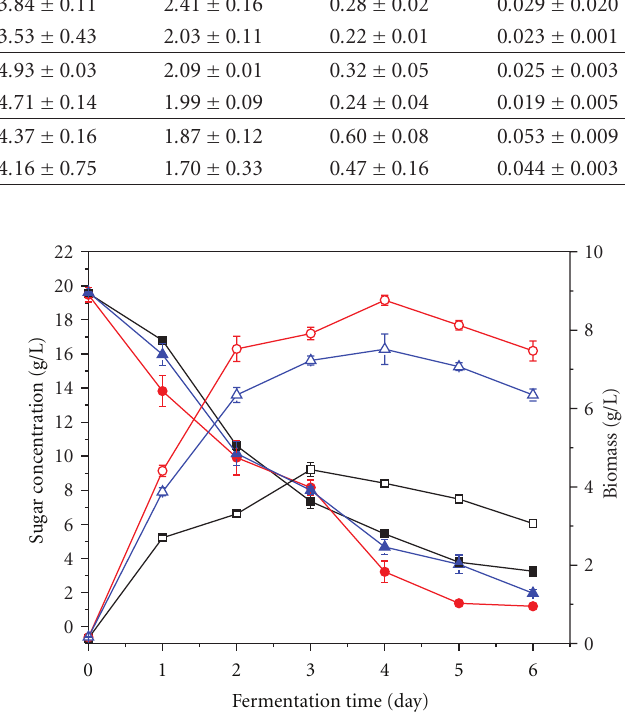
Figure 1: E ff ect of di ff erent types of DRBH on the growth of Y. lipolytica Po1g . Culture conditions: growth in Erlenmeyer flasks; initial total sugar concentration: 20 g/L; pH: 6.5; incubation tem- perature: 26 ◦ C; agitation speed = 150 rpm; biomass concentration: ( (cid:2) ) 2%, ( ◦ ) 3%, ( (cid:3) ) 4%; sugar consumption: ( (cid:3) ) 2%, ( • ) 3%, ( (cid:4) ) 4%.